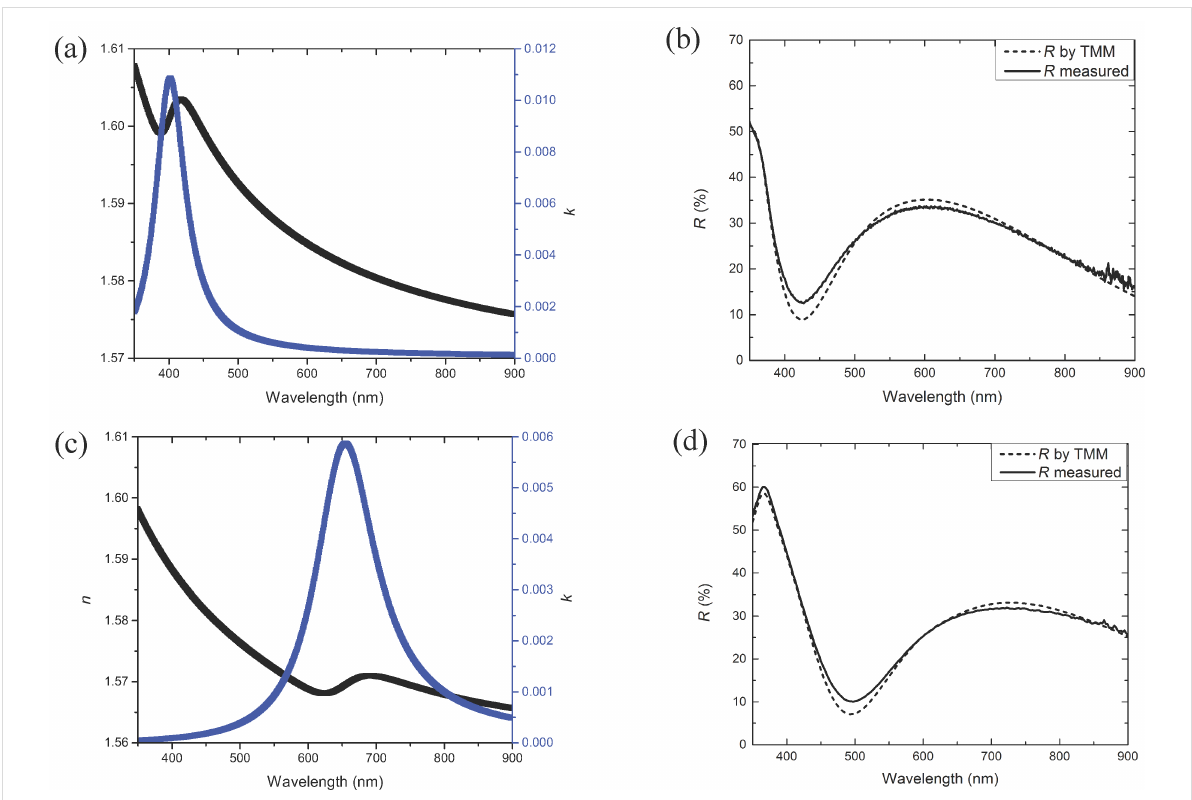
Figure 3: (a) Optical indices n and k , (b) reflectance measured and calculated by TMM for heterogeneous layers with nanospheres, (c) optical indices and (d) reflectance measured and calculated for heterogeneous layers with nanoprisms.